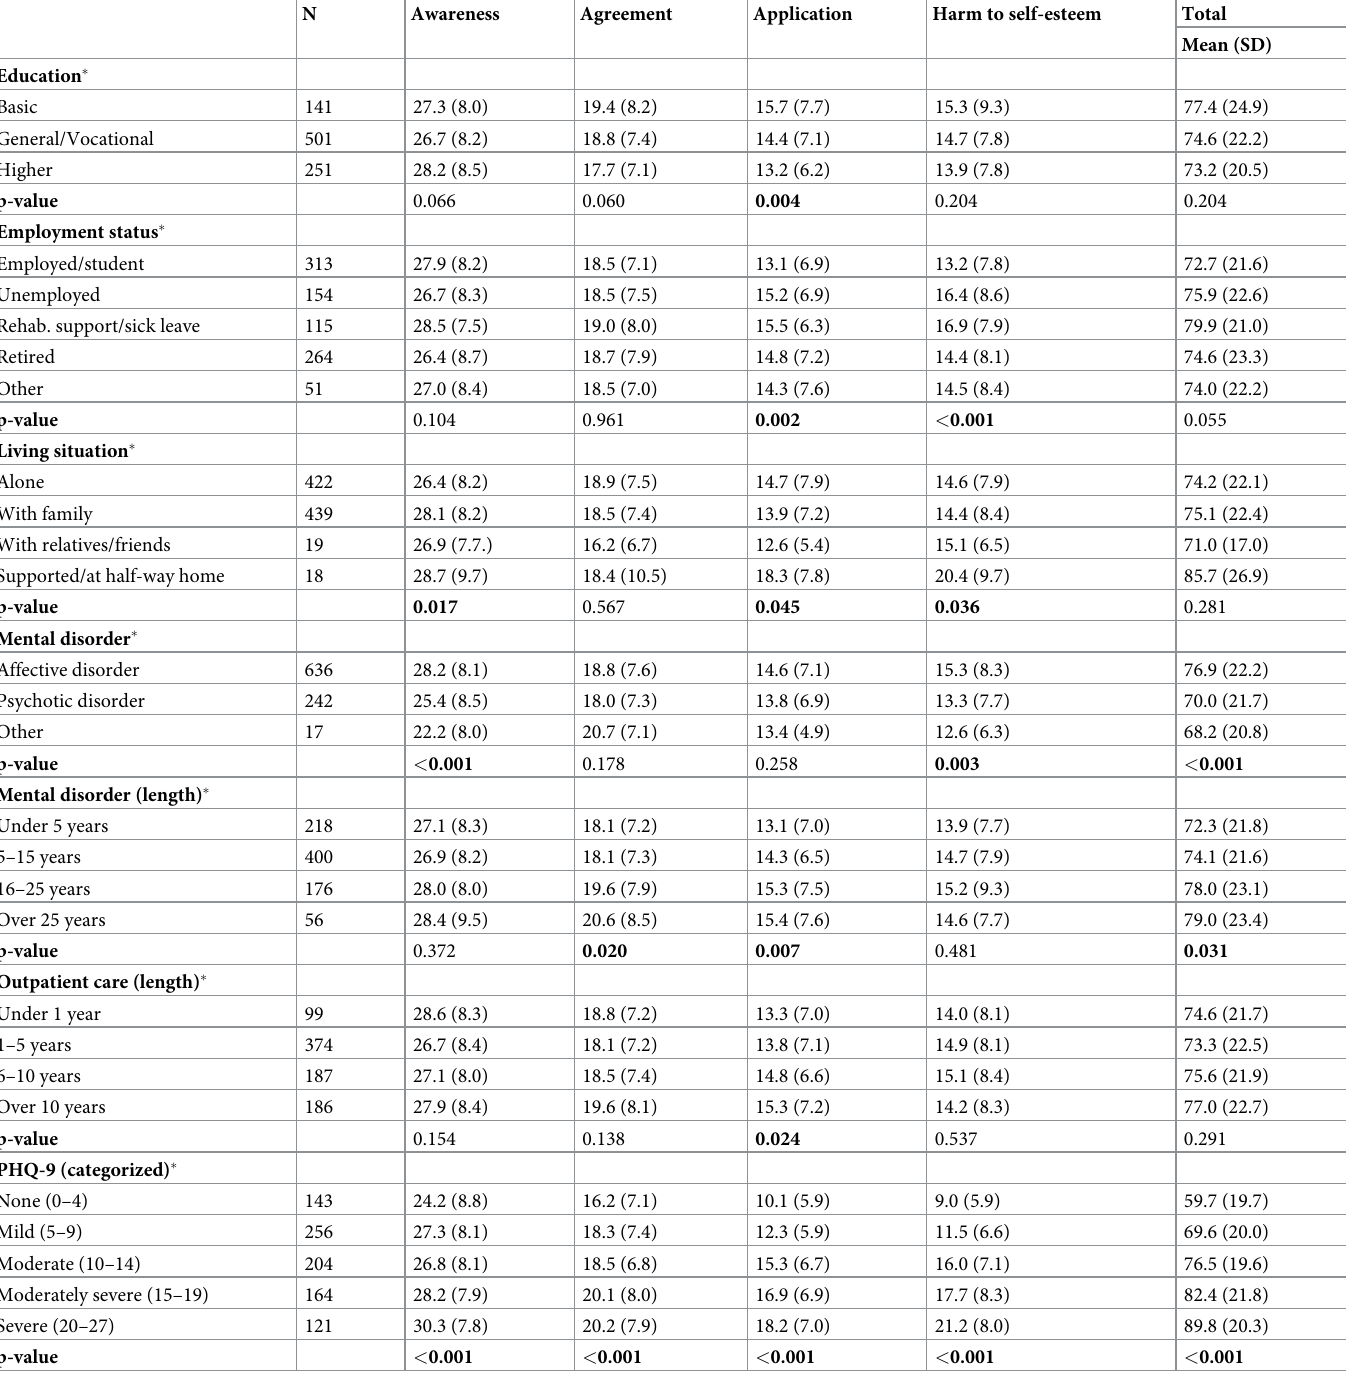
Table 3. Mean (SD) for each subscale in self-stigma for people with mental disorders (N = 898) using the SSMIS-SF in characteristics and depressive symptoms asso- ciated with self-stigma. N Awareness Agreement Application Harm to self-esteem Total